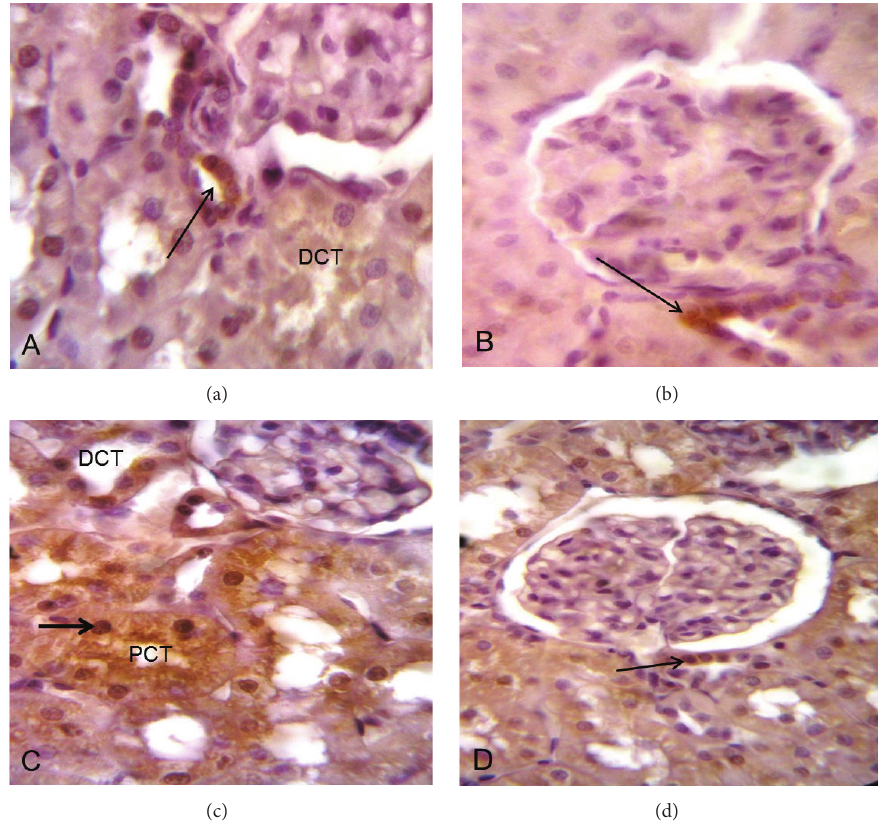
Figure 5: Effect of curcumin on localization of cyclooxygenase-2 (COX-2) immunoreactivity in rat renal cortex of methotrexate-induced nephrotoxicity in rats ( × 1000). ((a) and (b)) Sections from control and curcumin-treated groups show localized COX-2 expression in the macula densa cells (arrow). (c) Methotrexate-treated group shows high COX-2 expression in different degenerated cortical tubules. Note that some nuclei show positive COX-2 staining (arrow). (d) Methotrexate plus curcumin treated group shows little COX-2 staining in different corticaltubules. NotethatCOX-2staininginthemaculadensacells(arrow). PCT:proximalconvolutedtubule;